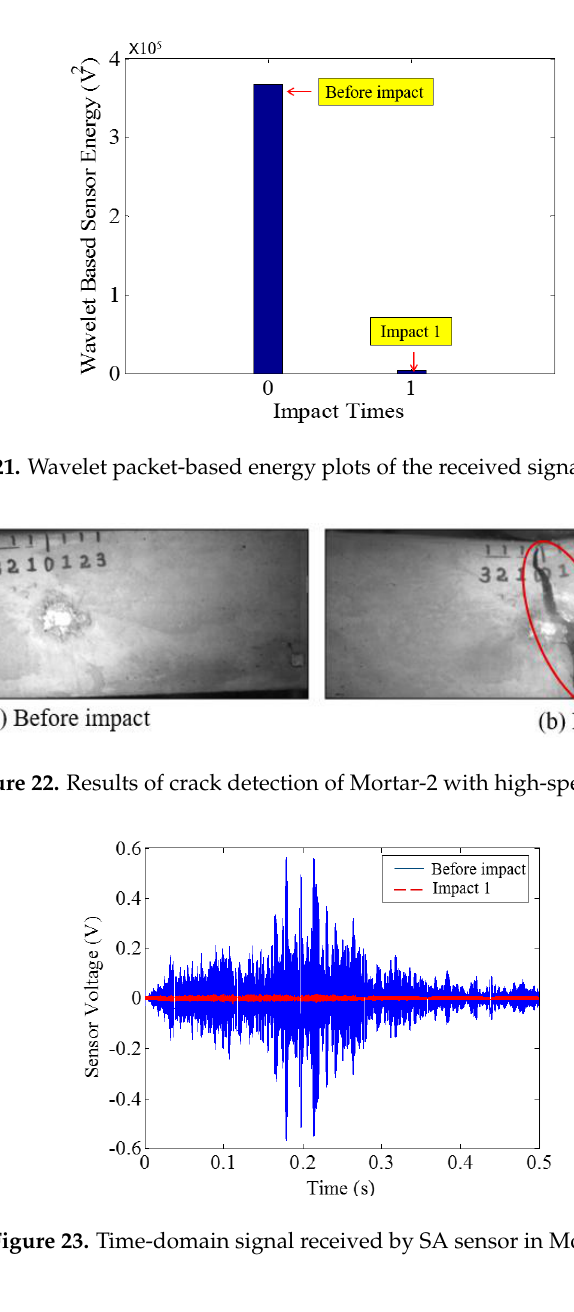
Figure 20. Time-domain signal received by SA sensor in Mortar-1. Figure 20 . Time-domain signal received by SA sensor in Mortar-1. Figure 20 . Time-domain signal received by SA sensor in Mortar-1. Figure 20 . Time-domain signal received by SA sensor in Mortar-1. Figure 20 . Time-domain signal received by SA sensor in Mortar-1.